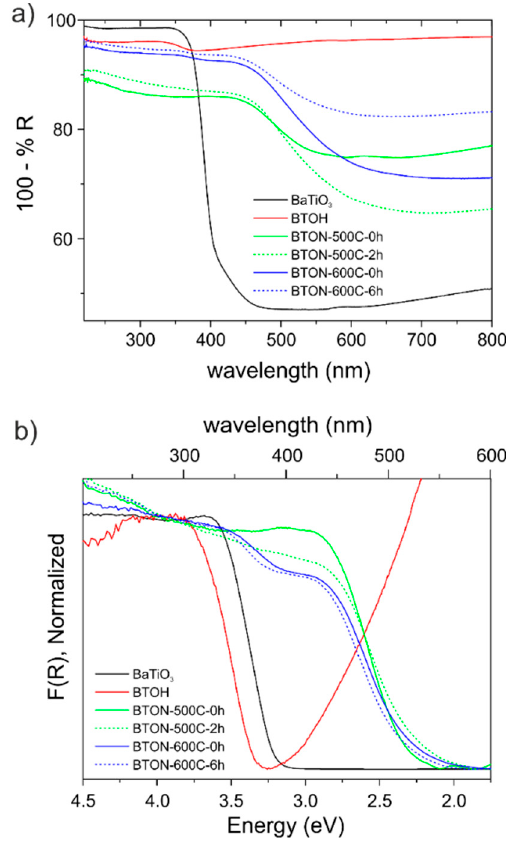
Figure 8. ( a ) Diffuse reflectance UV-VIS spectra of BaTiO 3 , BTOH, BTON-500C-0 h, BTON-500C-2 h, BTON-600C-0 h, and BTON-600C-6 h. ( b ) Normalized Kubelka–Munk function of the spectra.